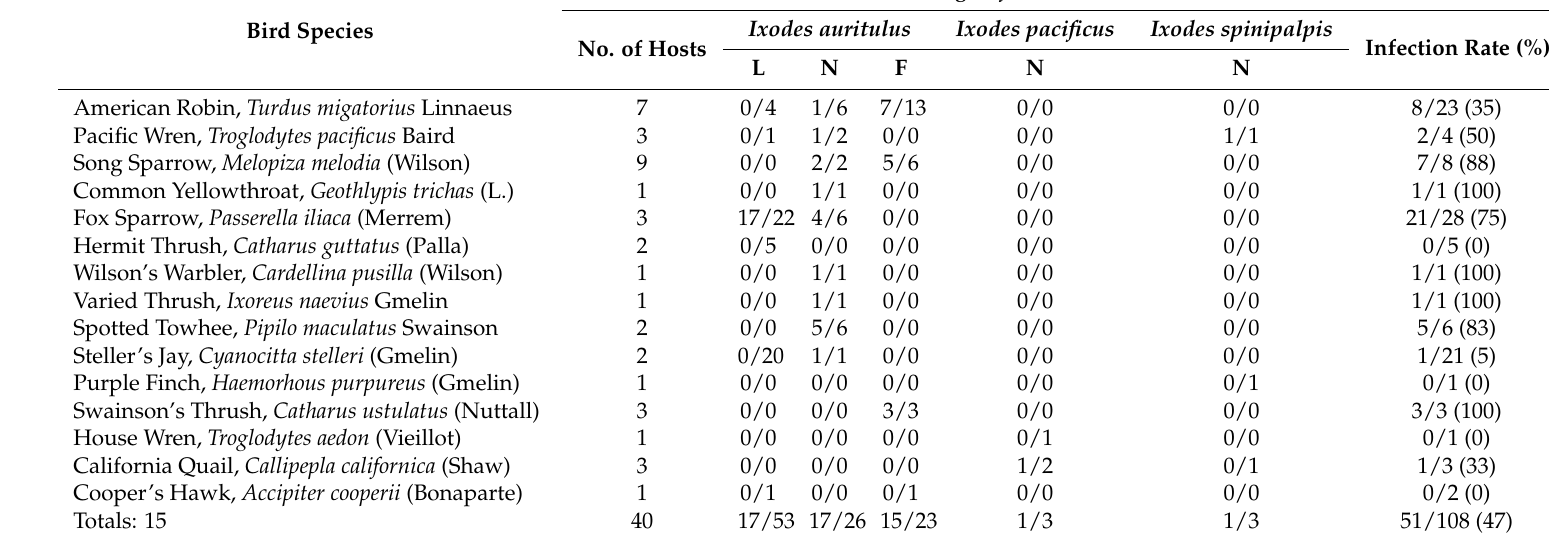
Table 2. Detection of Borrelia burgdorferi sensu lato in Ixodes ticks collected from avian hosts in the Metchosin-Victoria-Vancouver-Maple Ridge, British Columbia area,